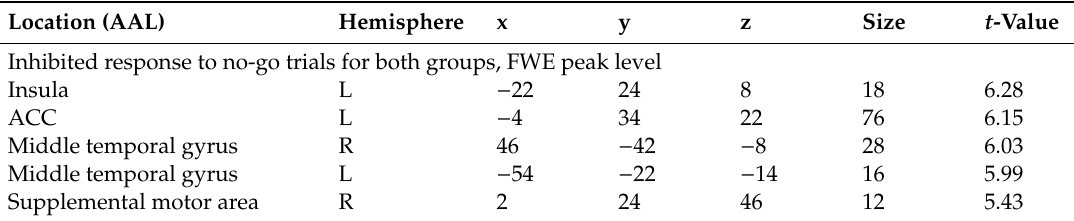
Table 3. Go / No-Go task